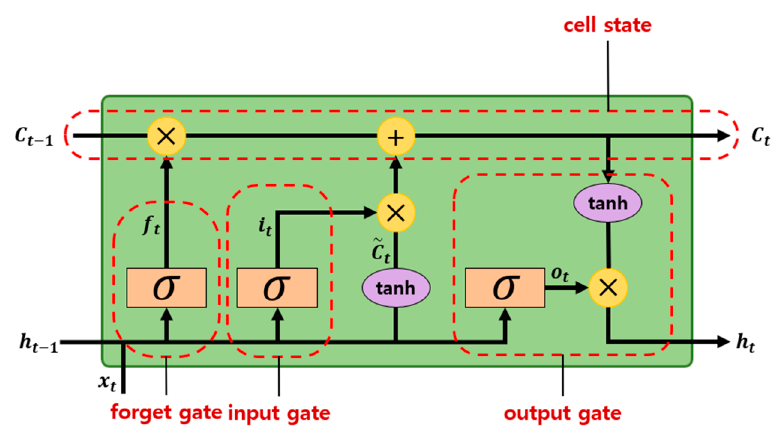
Figure 1. Long short-term memory (LSTM) cell.